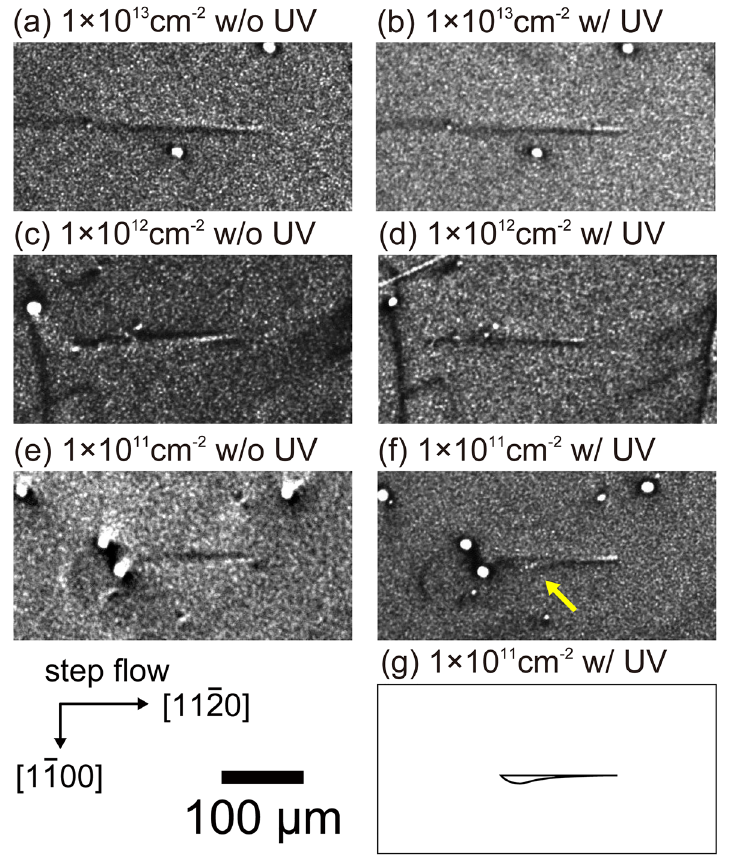
Figure 4. ( a )–( f ) X-ray topography images of specimens with proton irradiation fluence ranging from 1 × 10 11 to 1 × 10 13 cm −2 before and after UV illumination with power of 10 W cm −2 for 120 h and (g) schematic illustration of the shape of the SF shown in ( f ).